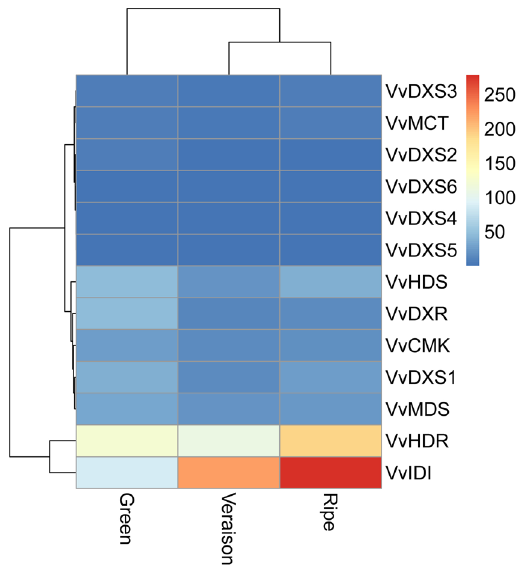
Figrue 6. Expression level of MEP pathway genes during grapevine ripening. Data were obtained by Illumina RNA Sequencing using two biological replicas and are expressed as Reads Per Kilobase of exon model per Million mapped reads (RPKM).